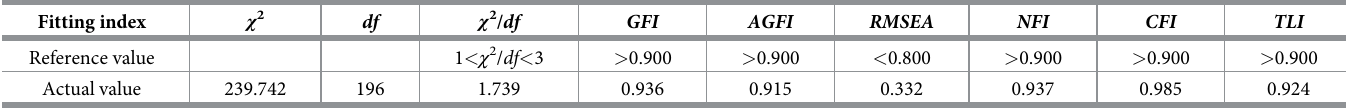
Table 10. Resident model fitting indicators.